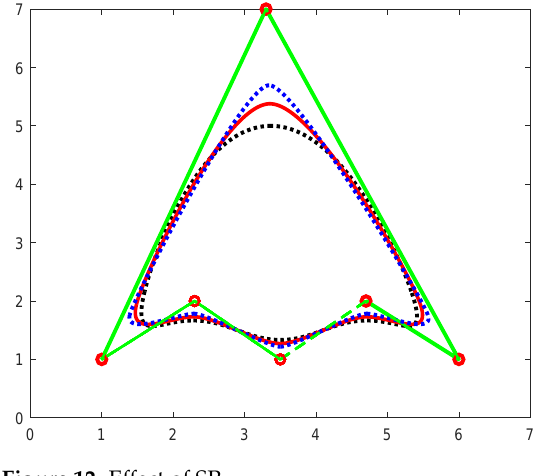
Figure 12. Effect of